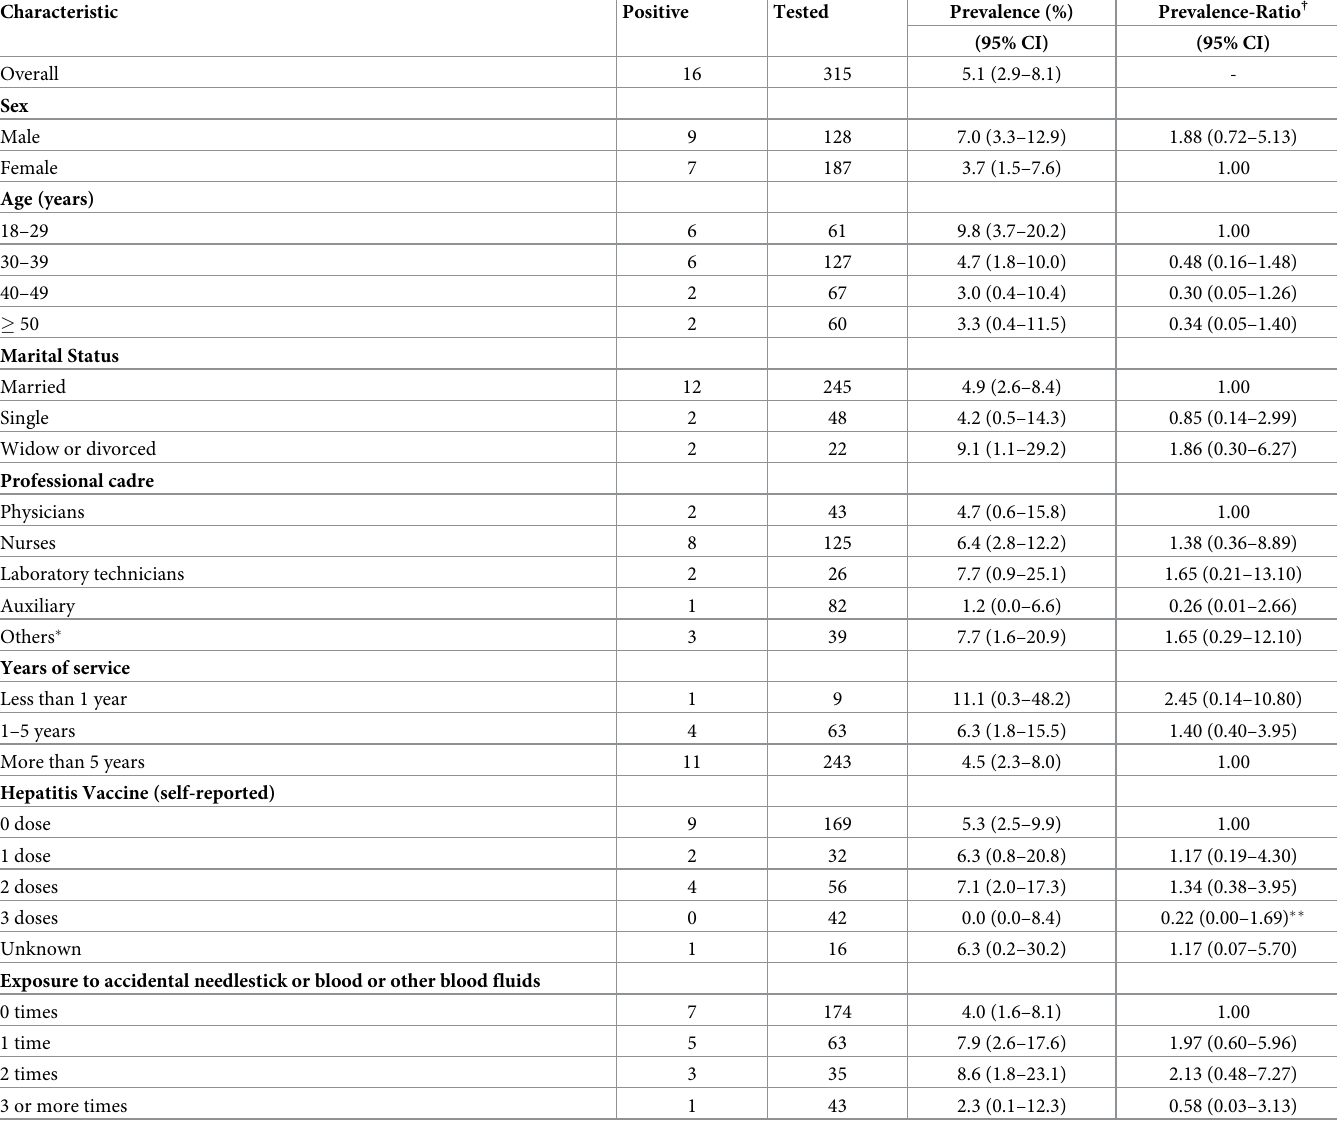
Table 2. Prevalence of hepatitis B infection per demographic